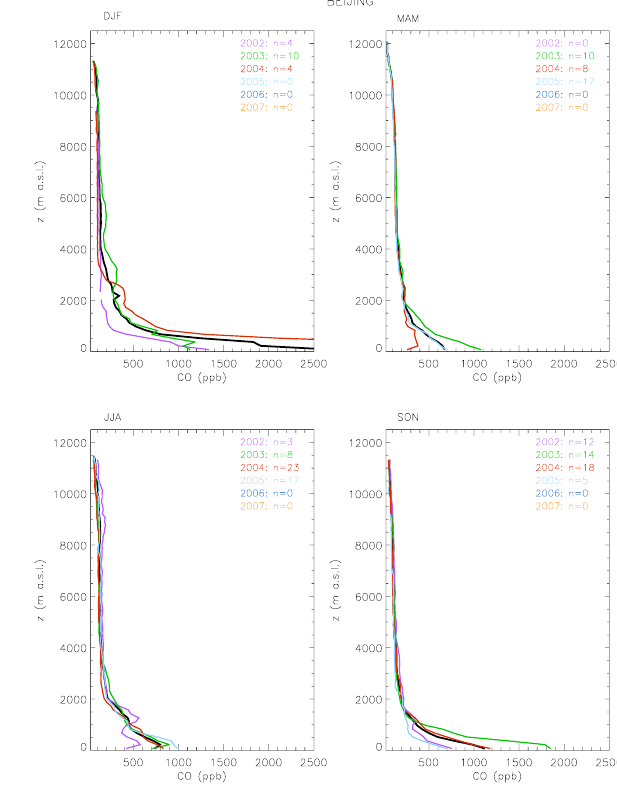
Fig. 2. Same as Fig. 1 but for